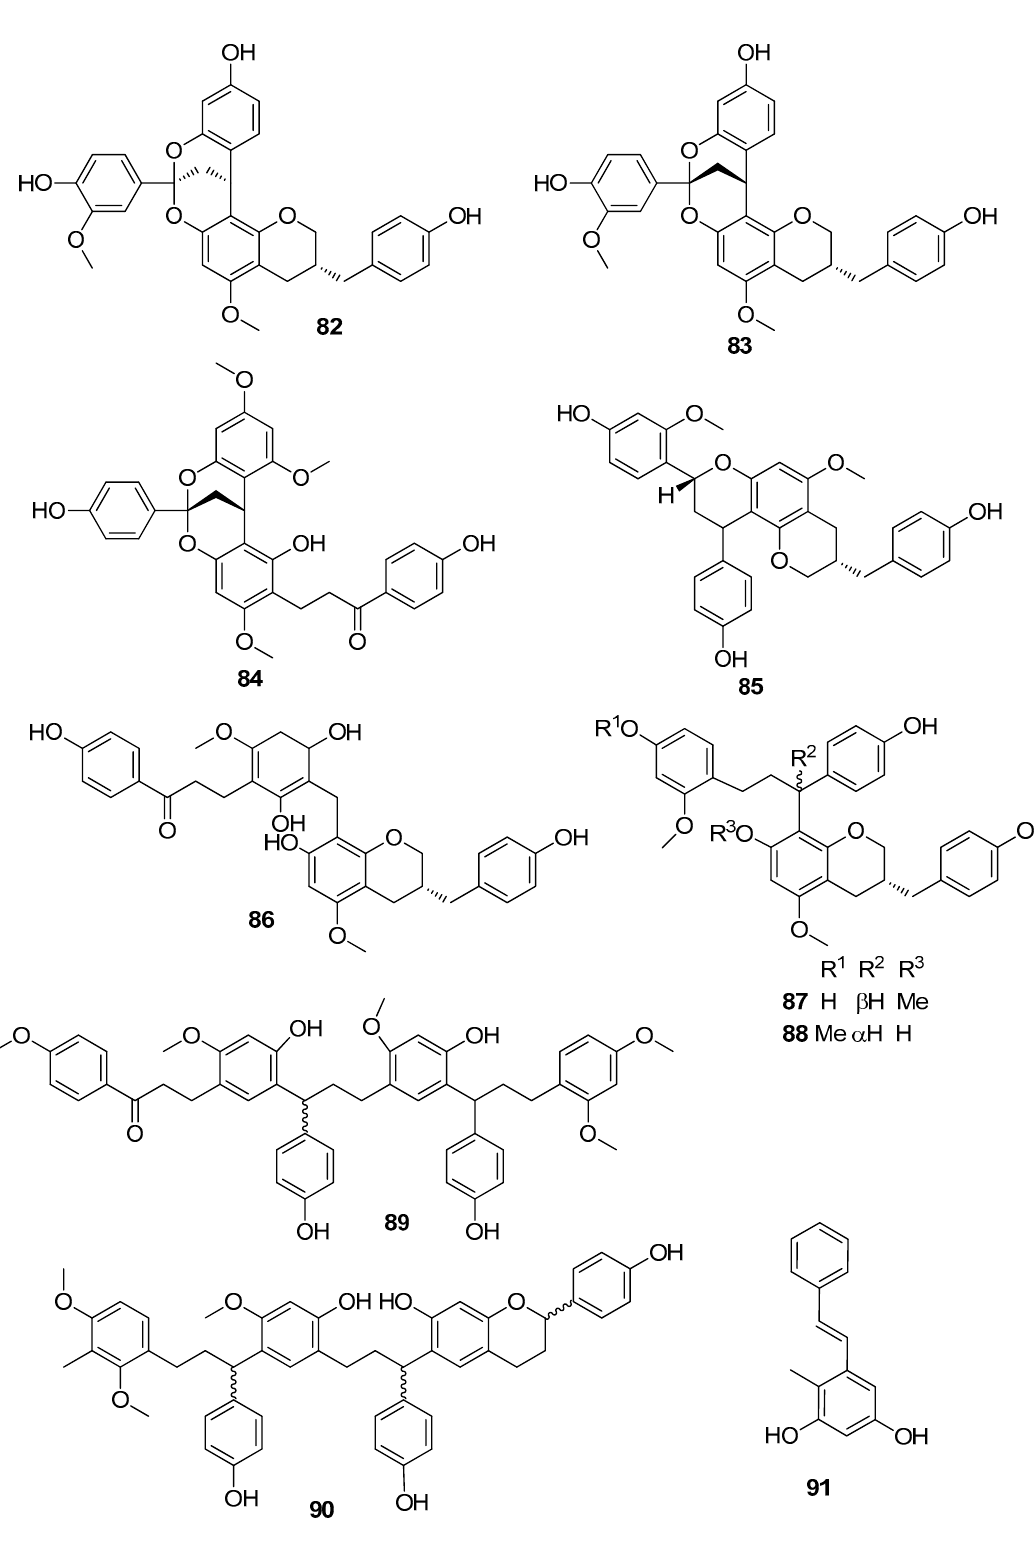
Figure 13. Selected flavonoid dimers ( cont .) and trimers from D. cochinchinensis red resin.